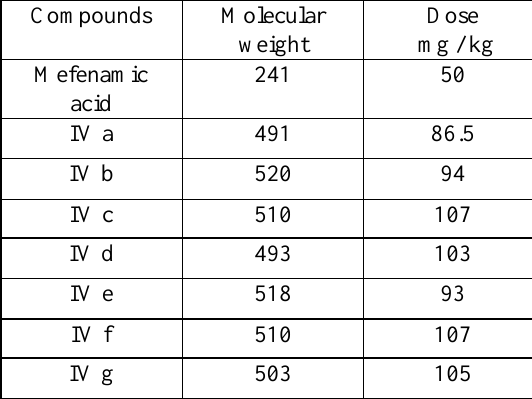
Table (3) Compounds with their molecular weight and dose Compounds Molecular weight